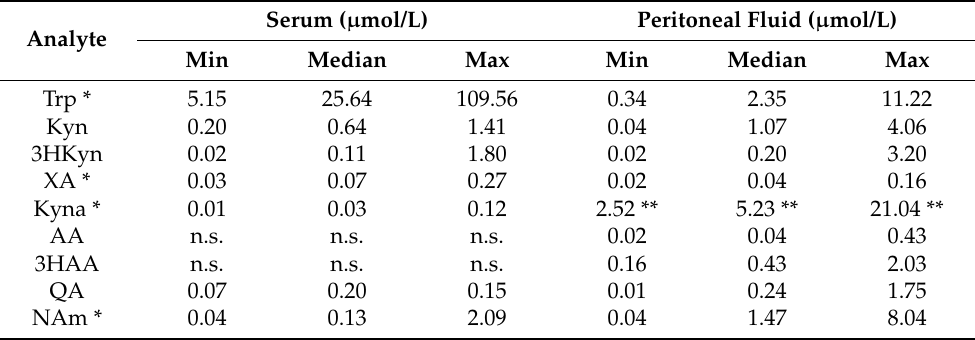
Table 5. Concentration ranges of Trp, NAm, and KP metabolites in the serum and peritoneal fluid from gastric cancer patients ( n =